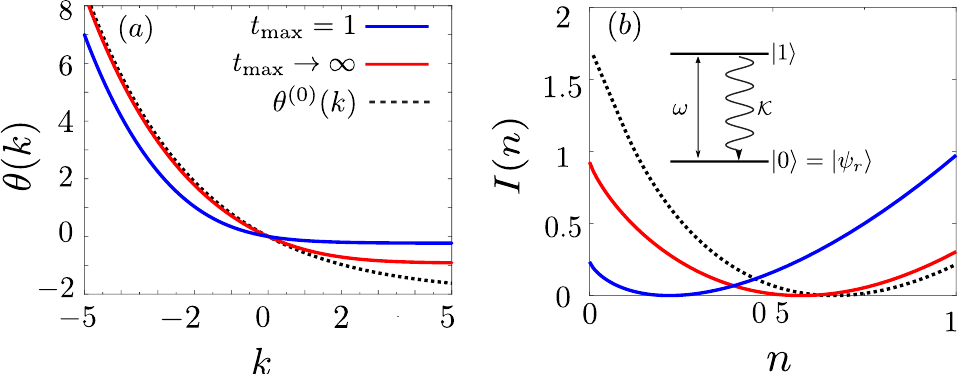
〉 = | 0 〉 . (a) Scaled cumu- Figure 2: Two-level system reset to the inactive state | ψ r = 1 (in units of ω − 1 , blue lant generating function θ ( k ) as a function of k for t max → ∞ (red solid line). The SCGF of the reset-free dissipative solid line) and t max process θ ( 0 ) ( k ) is shown as a black dashed curve for comparison. (b) Rate function I ( n ) as a function of the activity n = N / t for the same values of t as in panel max (a). The two-level system is also sketched. Resetting favours the population of the inactive state | 0 〉 and therefore lowers the activity of the system. In the Figure we set γ = 0.3 and K = 4 in units of ω